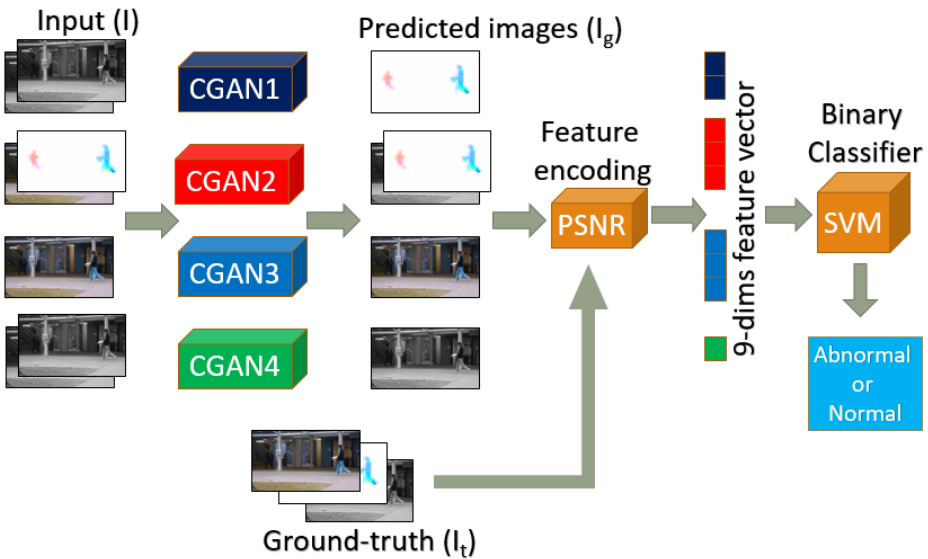
Figure 1. Our multi-channels pix2pix-CGANs framework for anomaly detection. In each CGAN stream, the number of channels and the type of each channel for input image (i.e., source image I ) and output image (i.e., generated or predicted image I g ) are different. CGAN1 takes 2 grayscale channels as input and 2 optical flow channels as output. CGAN2 takes 1 grayscale channel and 2 optical flow channels as input, then 1 grayscale channel and 2 optical flow channels as output. CGAN3 takes 3 RGB channels as input and 3 RGB channels as output. CGAN4 takes 2 grayscale channels as input and 1 grayscale channel as output. The configuration is described in detail in Table 1. The channels of generated images are similar to the channels of ground-truth images (i.e., target images I t ). Best viewed in